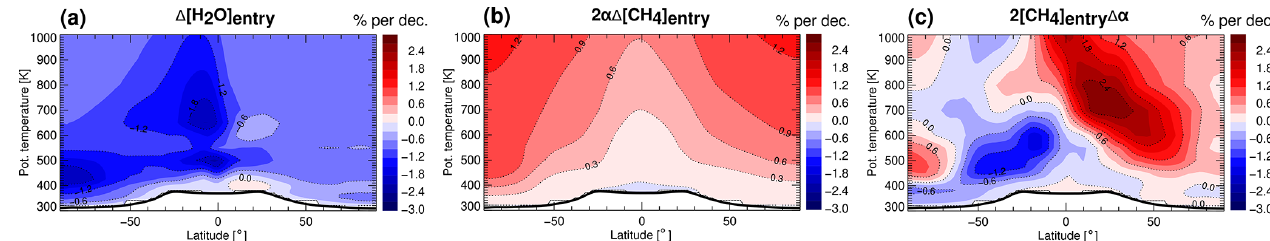
Figure 2. Contributions to long-term changes in H 2 O 1990–2017 from the FULL method. Contributions to stratospheric H 2 O trends for 1990–2017 from (a) stratospheric H 2 O entry mixing ratio changes, (b) stratospheric CH 4 entry mixing ratio changes, and (c) circulation changes. Stratospheric entry H 2 O and CH 4 are derived through propagation of their stratospheric entry mixing ratios by convolution with the CLaMS modelled age spectrum. The data are from CLaMS simulations driven by ERA-Interim reanalysis and are presented in percentage per decade, with relation to the climatological 1990–2017 stratospheric H 2 O mixing ratios. The black line is the (lapse rate) tropopause calculated from ERA-Interim using the WMO definition (WMO, 1957). The white region below the tropopause denotes the region where the reconstruction method can not be applied.